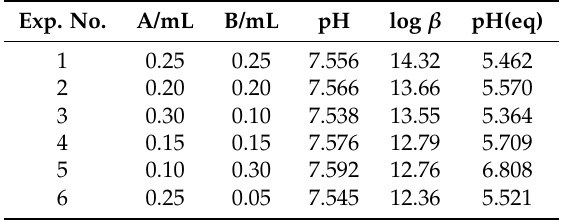
Table 1. Compositions of mixtures for turbidimetry. Solution C is added up to a total volume of 3 mL. Exp. No. A/mL B/mL pH log